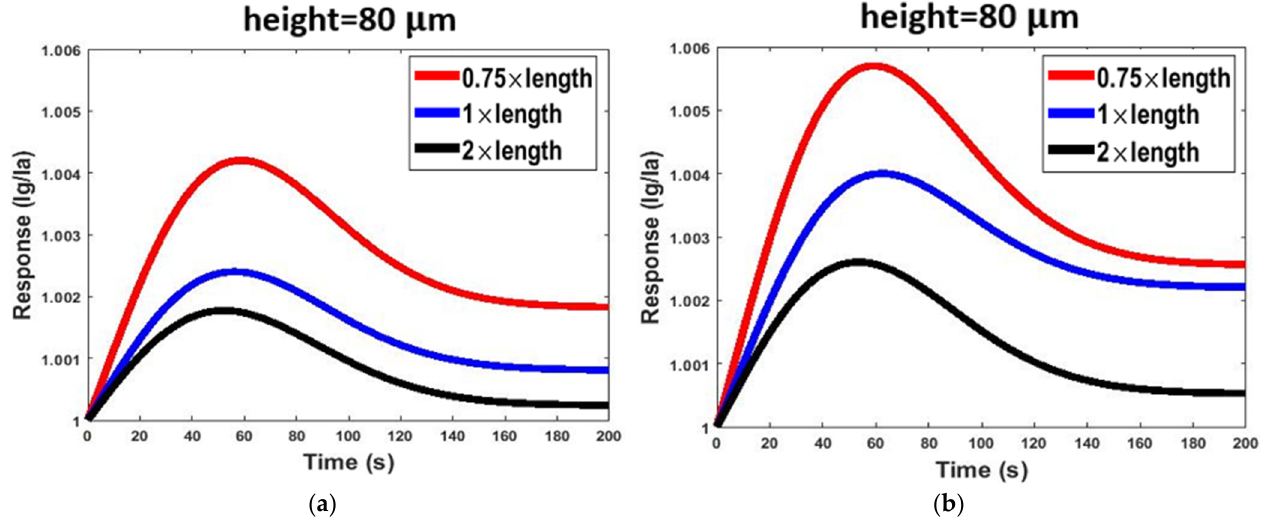
Figure 6. The effect of length variation of the channel on the responses of two sensor structures at 2.6 ppm concentrations of acetone gas operated at room temperature: ( a ) serpentine model and ( b ) simple model.